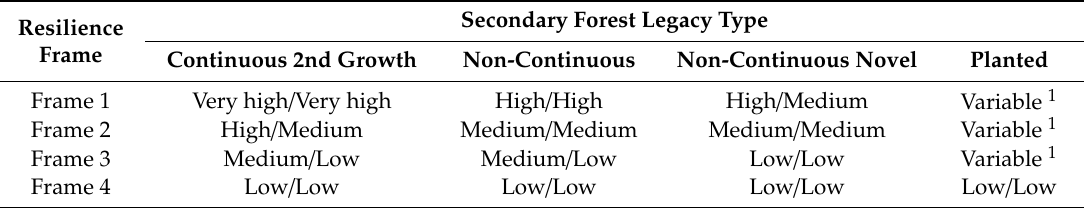
Table 1. Forest resilience levels by frame and forest legacy type. Each cell shows the two levels of forest resilience to climate change: for high (left) and low (right) levels of landscape diversity. Resilience depends on ecosystem legacy / memory and resilience debt as explained in the text. Frame 5 is not considered here, since such forest by definition would be planted in the future using non-native species or bioengineered native species that do not fit within any of the legacy types shown